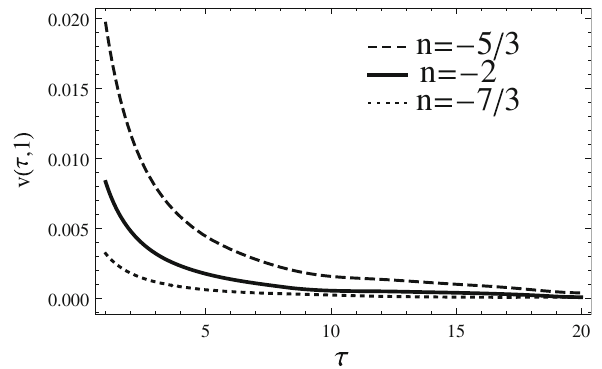
Fig. 7 Energy density (cid:3)(τ, x )/(cid:3) c versus x plot at τ 1 = 1 fm with different values of n . The dashed, solid and dotted curves correspond to n = − 5 / 3 , − 2 and − 7 / 3, respectively